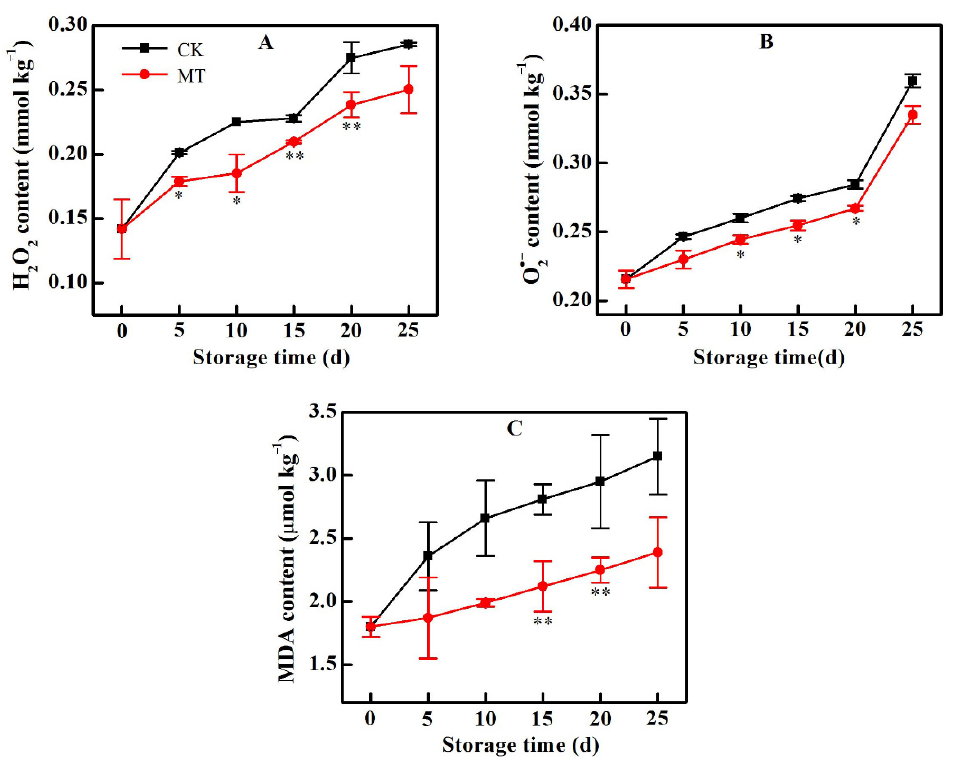
Figure 3. Change in the contents of H 2 O 2 ( A ), O 2 •− ( B ) and MDA ( C ) in horn pepper fruit during cold storage after treatment with water (CK) or melatonin (MT). Asterisks * and ** indicate the significant differences ( p < 0.05 or p < 0.01, respectively) between treatments.